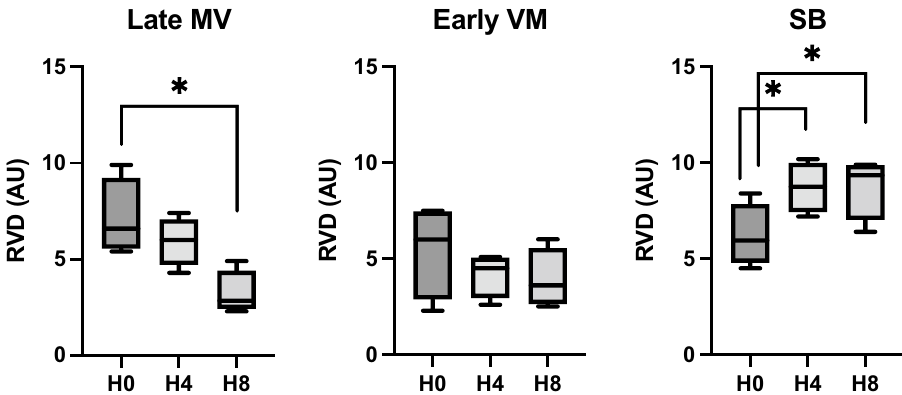
Figure 6. Regional ventilation delay values from SB and Early MV and Late MV groups. MV mechanical ventilation, SB spontaneous breathing, RVD regional ventilation delay, AU arbitrary units. * p < 0.05, using GLMM for the SB-group, and the Friedman test for the Late VM group.